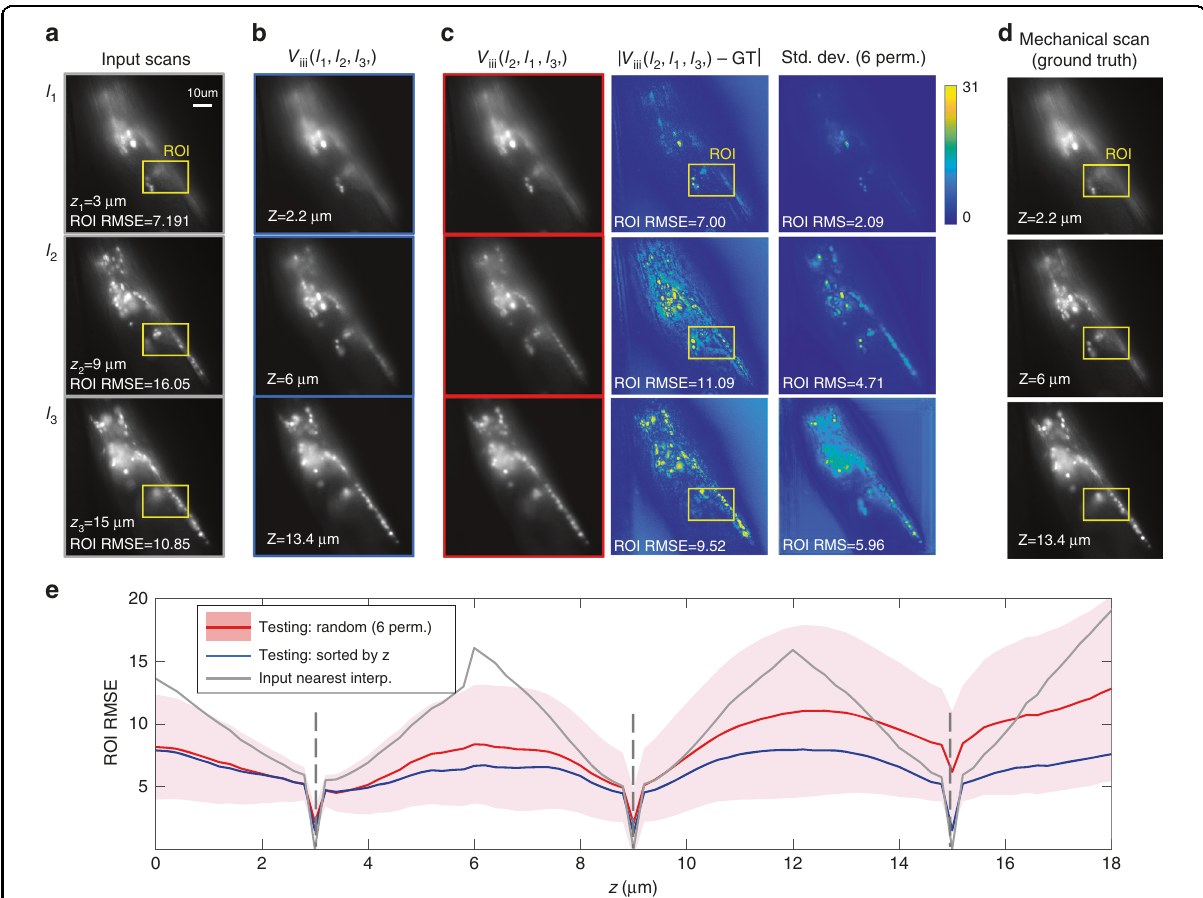
Fig. 6 Permutation invariance of Recurrent-MZ to the input images. Recurrent-MZ was trained with inputs ( M = 3) sorted by z and tested on new samples with both inputs sorted by z as well as 6 random permutations of the same inputs to test its permutation invariance. a The input images sorted by z , and the RMSE values between the ground truth image and the corresponding nearest input image are shown. b The Recurrent- MZ outputs of the input sequence ( I 1 , I 2 , I 3 ), c the test outputs with input sequence ( I 2 , I 1 , I 3 ), the corresponding difference maps and the pixel-wise standard deviation over all the 6 random permutations, d the ground truth images obtained by mechanical scanning through the same sample, acquired with an axial spacing of 0.2 μ m, e red solid line: the average RMSE of the outputs of randomly permuted input images; pink shadow: the standard deviation RMSE of the outputs of randomly permuted input images; blue solid line: the RMSE of the output of input images sorted by z ; gray solid line: the RMSE value of the nearest interpolation using the input images, calculated with respect to the ground truth images. Gray dashed lines (vertical) indicate the axial positions of input images. RMSE and RMS values were calculated based on the yellow highlighted ROIs. The range of grayscale images is 255, while that of the standard variance images is